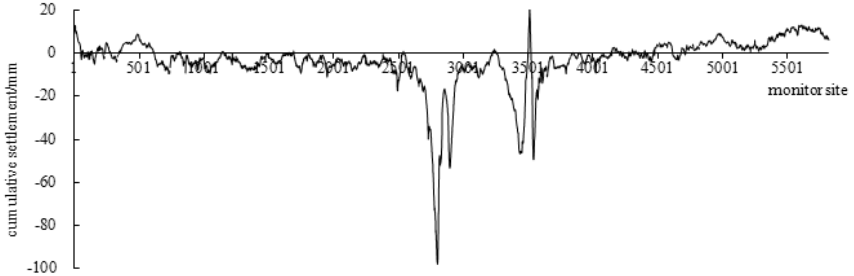
Figure 3. Graph of cumulative settlement of C from 2008 to 2010.